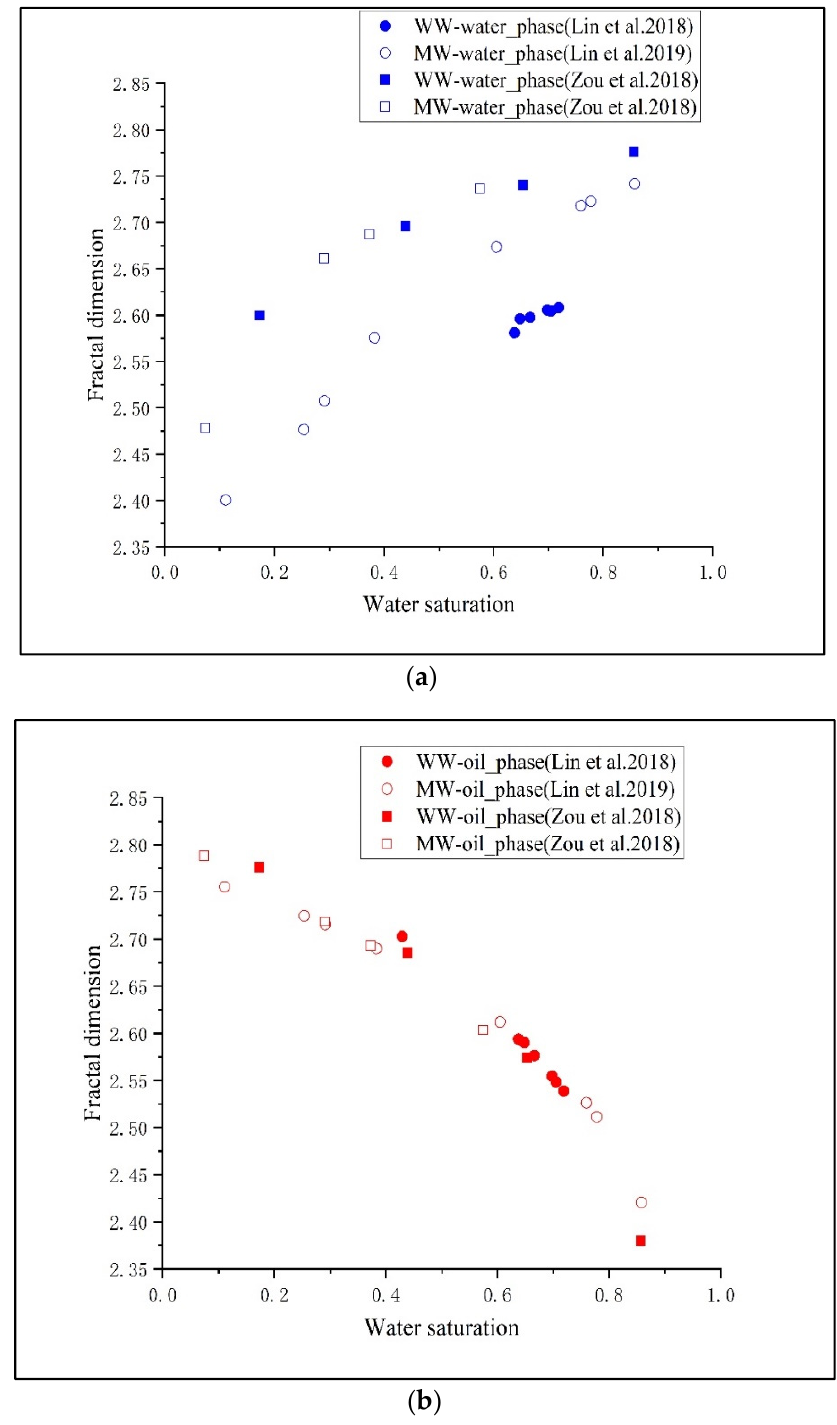
Figure 3. Comparison of fractal dimensions for water phase ( a ) and oil phase ( b ) in water-wet and mixed-wet cases.